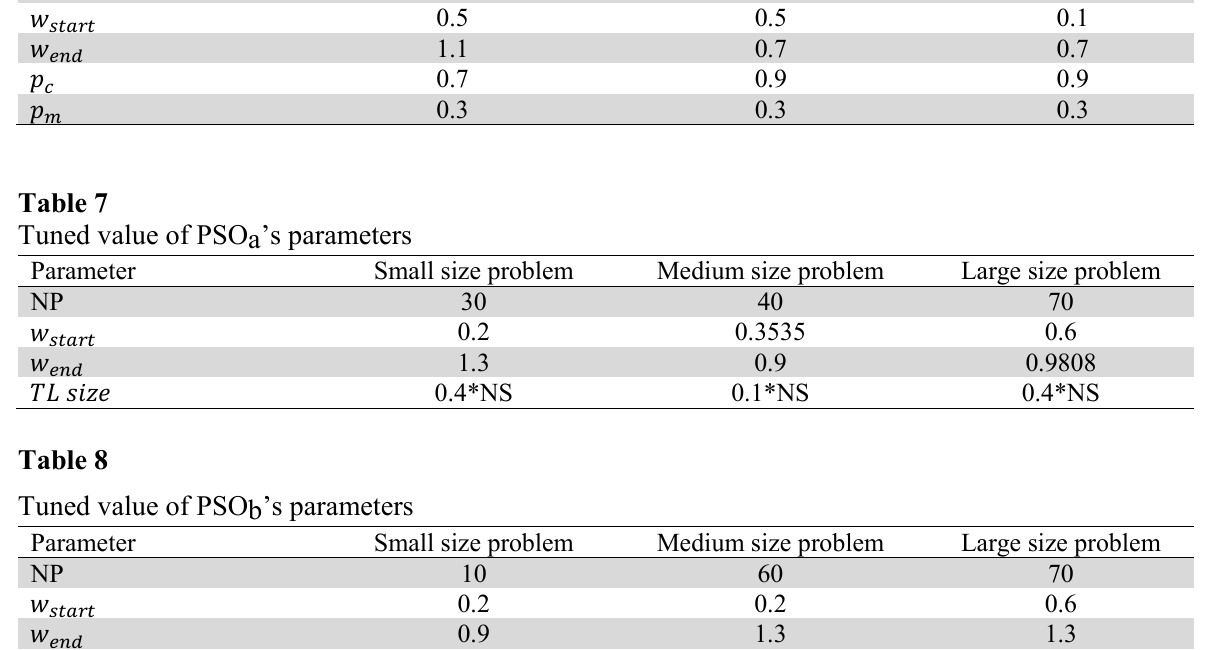
the different PSO-GA control parameters. Tuned value of PSO-GA’s parameters Parameter